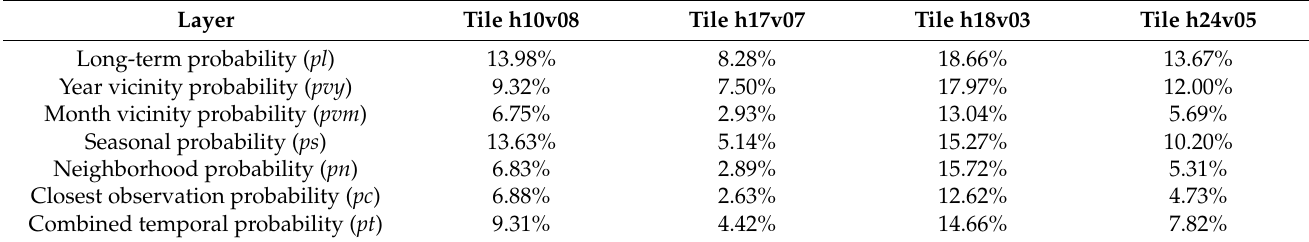
Table 1. Mean bias of temporal layers regarding the highest variability evaluation range for each test ROI.